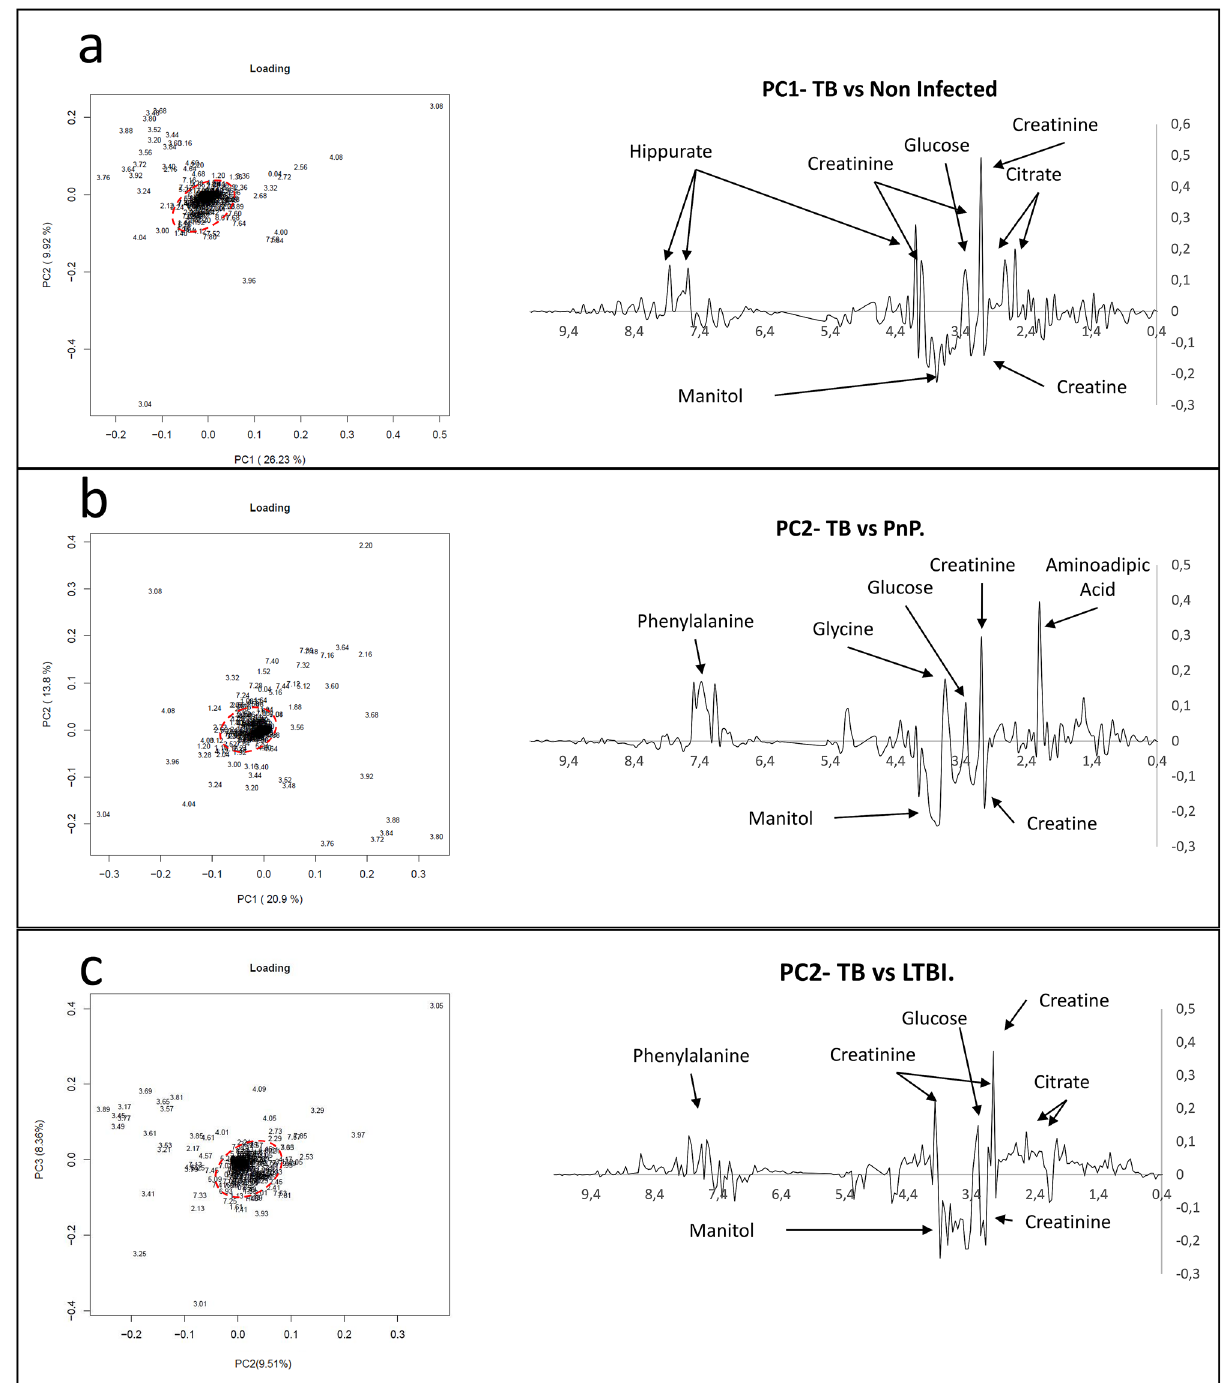
Figure 3. Principal Component Analysis (PCA) loading plots of 89 urine spectra analyzed by high-field Nuclear Magnetic Resonance reveals the metabolomic fingerprint of TB corresponding to 31 chemical shift regions assigned to eight metabolites. ( a ) PCA loading PC1-PC2 biplot and PC1 loading plot between TB patients and uninfected individuals; ( b ) PCA loading PC1-PC2 biplot and PC2 plot between TB patients and patients with pneumococcal pneumonia (PnP); ( c ) PCA loading PC2-PC3 biplot and PC2 loading plot between TB patients and individuals with LTBI. Multiple regions for the discrimination between groups were pointed outside the boundaries of a Hotelling’s T2 statistics ellipse (pointed red line) in PCA loading biplots. TB, tuberculosis; PnP, pneumococcal pneumonia; LTBI: latent TB infection; PC, Principal